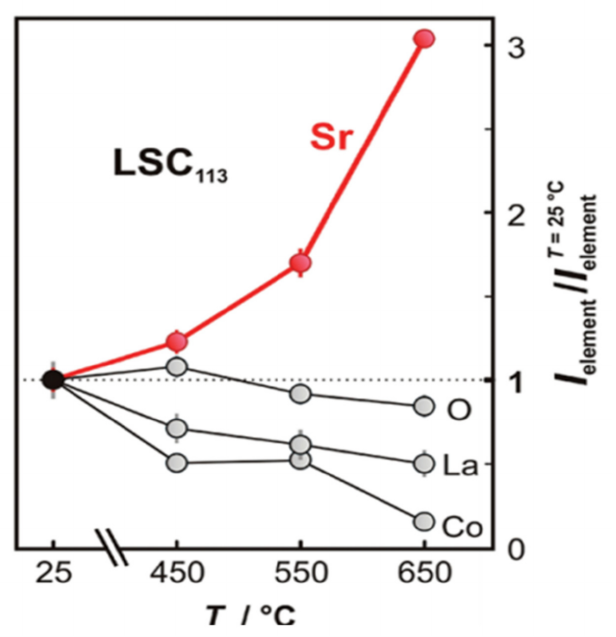
Figure 8. Increase in total Sr intensity with increasing temperature. (Reprinted with permission from [40], copyright American Chemical Society, 2012).